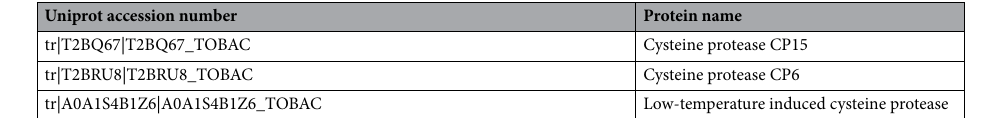
Table 1. Cysteine proteases detected in the eluted fraction containing unprocessed cardosin B by mass